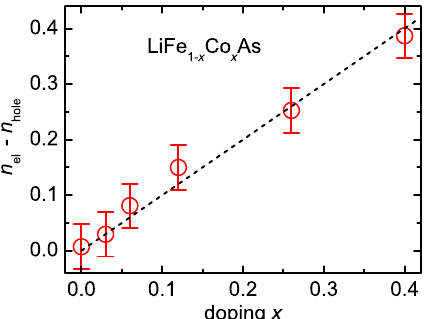
FIG. 10. Total electronic carrier concentration (open circles) determined from the total algebraic Fermi surface volume at each Co concentration x . The dashed line corresponds to the carrier concentration assumed by adding one extra electron for each Fe substituted by Co.